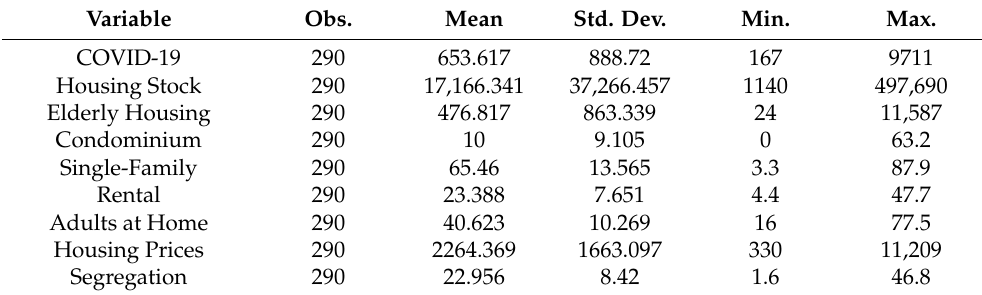
Table 1. Descriptive